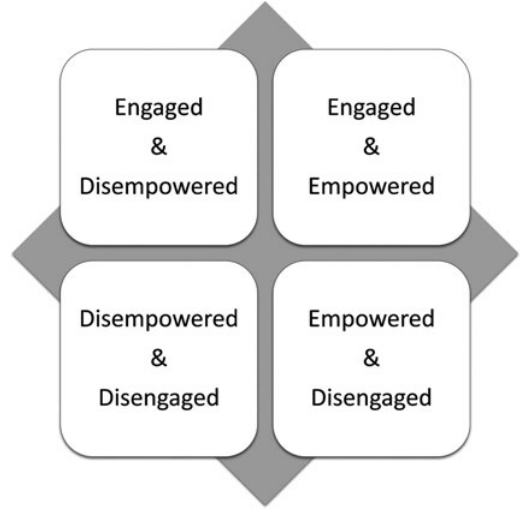
FIGURE 1 Exercise Four: Engagement and Empowerment.